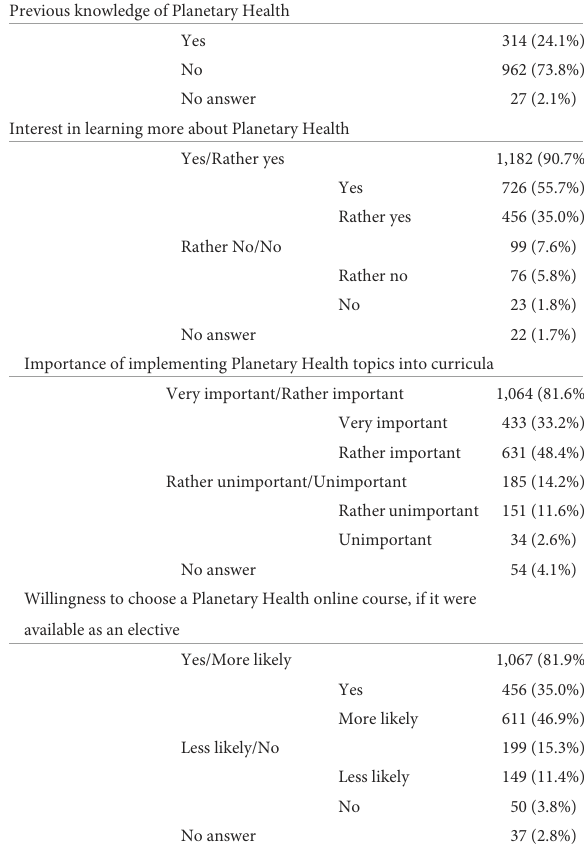
TABLE 2 Previous knowledge of and interest in Planetary Health, as well as importance of and willingness to choose a Planetary Health online elective ( N =